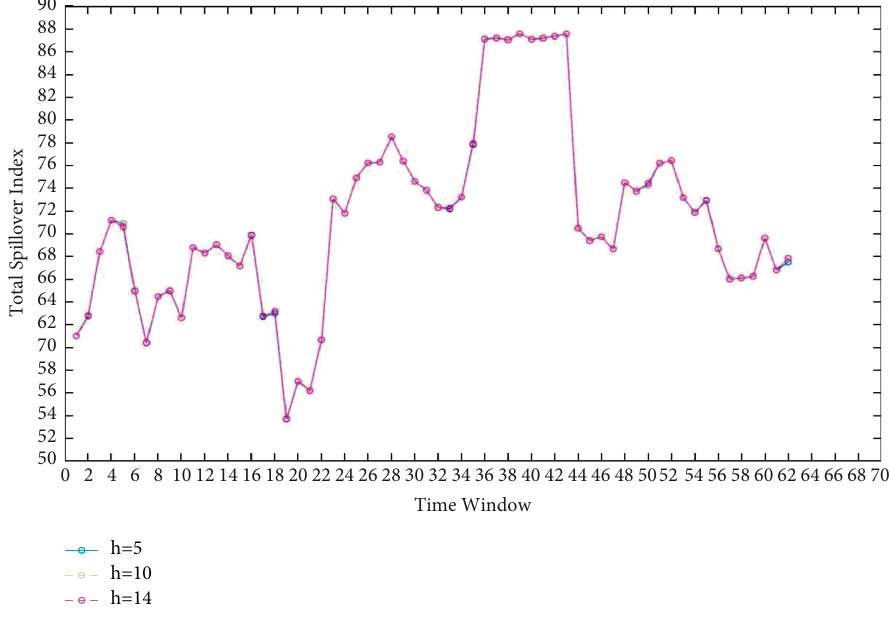
Figure 5: Total spillover index (volatility spillovers).